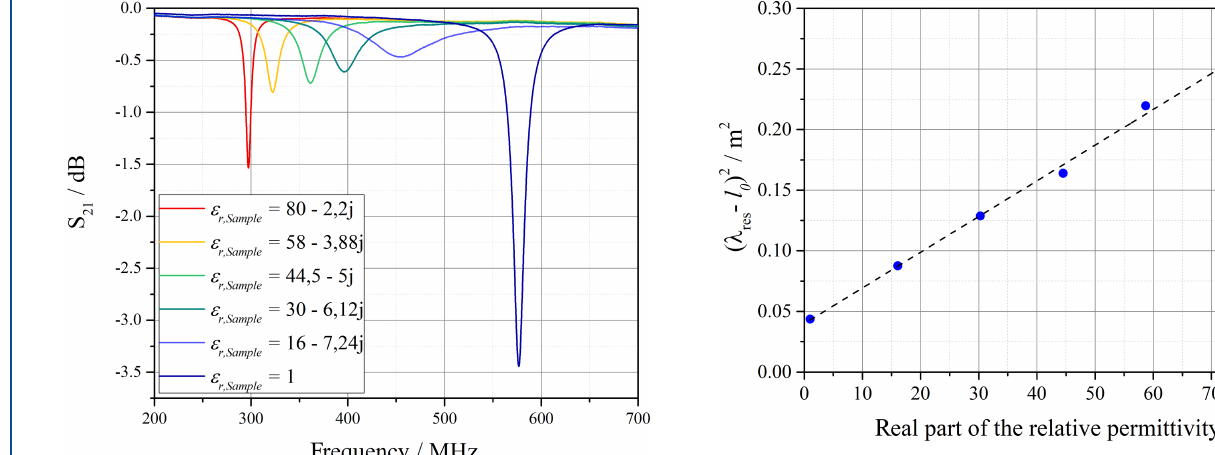
Figure 7. Transmission measurement for different mixtures of wa- ter and isopropanol in the sample container.